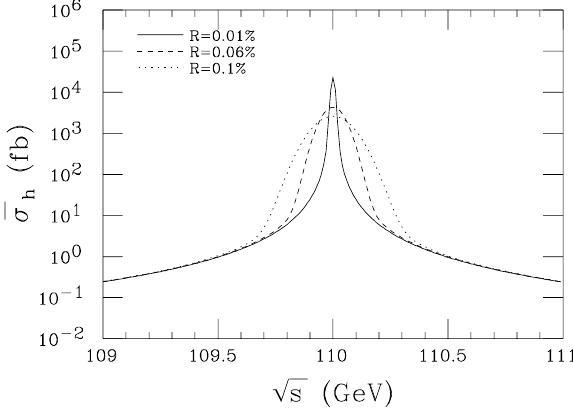
FIG. 5. Effective s -channel Higgs cross section ¯ s h obtained by convoluting the Breit-Wigner resonance formula with a Gaussian distribution for resolution R . From Ref.